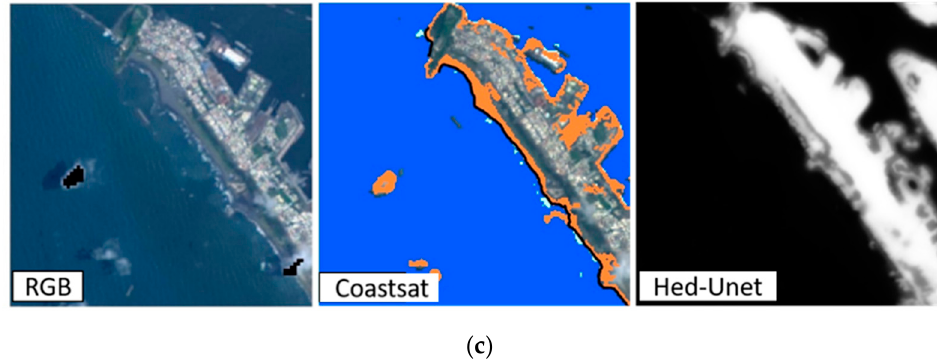
Figure 14. Comparison of sea–land segmentation results under atmospheric interference ( a ) waves ( b ) fog ( c ) clouds.